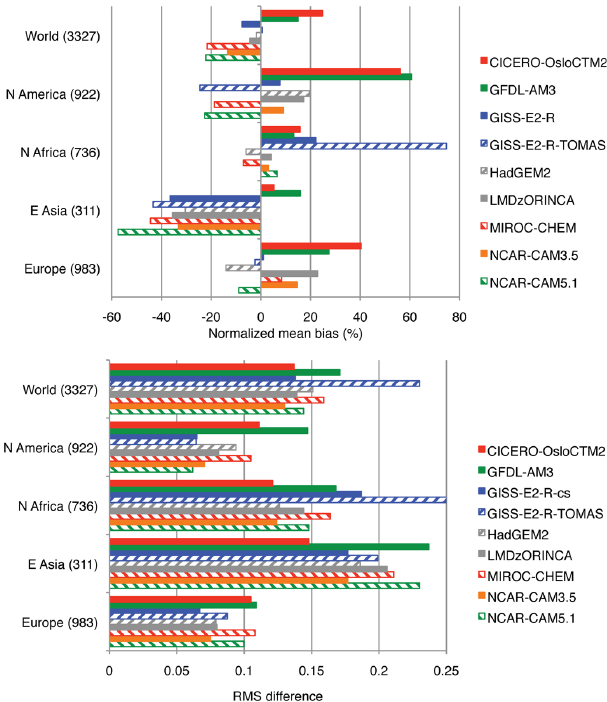
Fig. 4. Regional normalized mean biases (%; top) and root-mean- square differences (bottom) in AOD compared with AeroNet. The value in parentheses after each region’s name is the number of valid monthly observations within the region. The GISS-E2-R-TOMAS RMS value for North Africa goes off the scale to